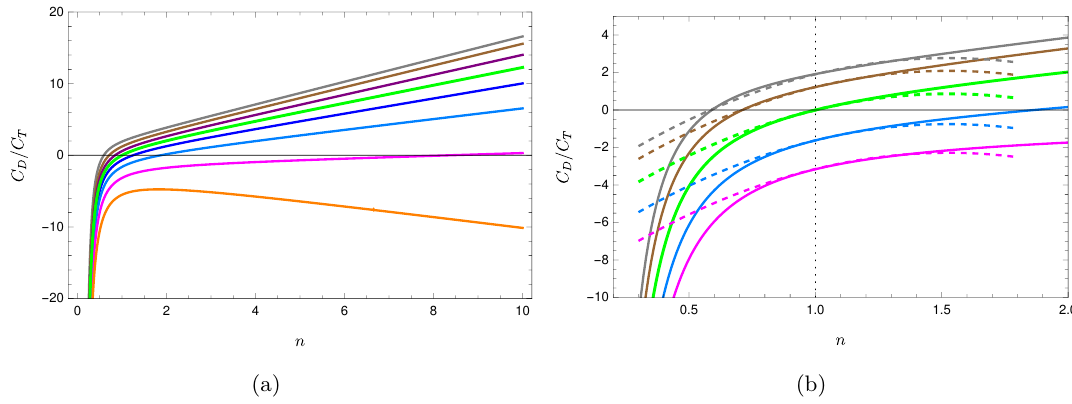
Figure 7 . Plots of C D /C T , defined in eqs. (3.13) and (3.35), as a function of n in d = 5 . The colours correspond to different fixed values of the chemical potential ˜ µ in eq. (3.37) with ‘ (a) The different curves correspond to ˜ µ 2 = ± 0 . 04 , ± 0 . 09 , ± 0 . 16 , 0 . 25 , with ˜ µ 2 increasing from top to bottom. We highlight in green the curve corresponding to ˜ µ = 0 . Note that ˜ µ 2 can be negative, as the chemical potential can take imaginary values. (b) Zoom of the same plot around the region close to n = 1 . The dashed lines correspond to the analytic expansions in eq. (D.8). Curves with the same colours correspond to the same chemical potential.